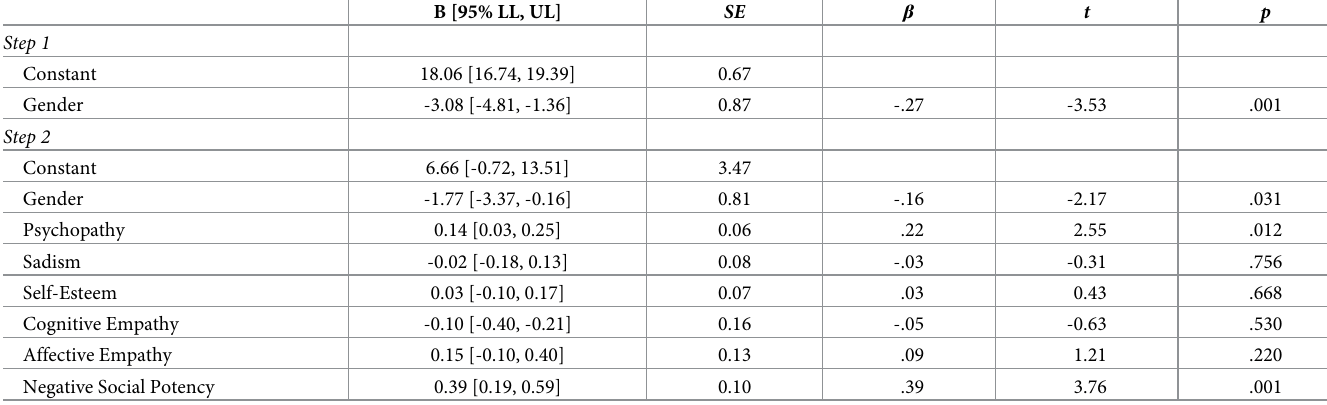
Table 4. Coefficients for gender, psychopathy, sadism, self-esteem, cognitive empathy, affective empathy, and negative social potency regressed on criterion of trolling. B [95% LL,